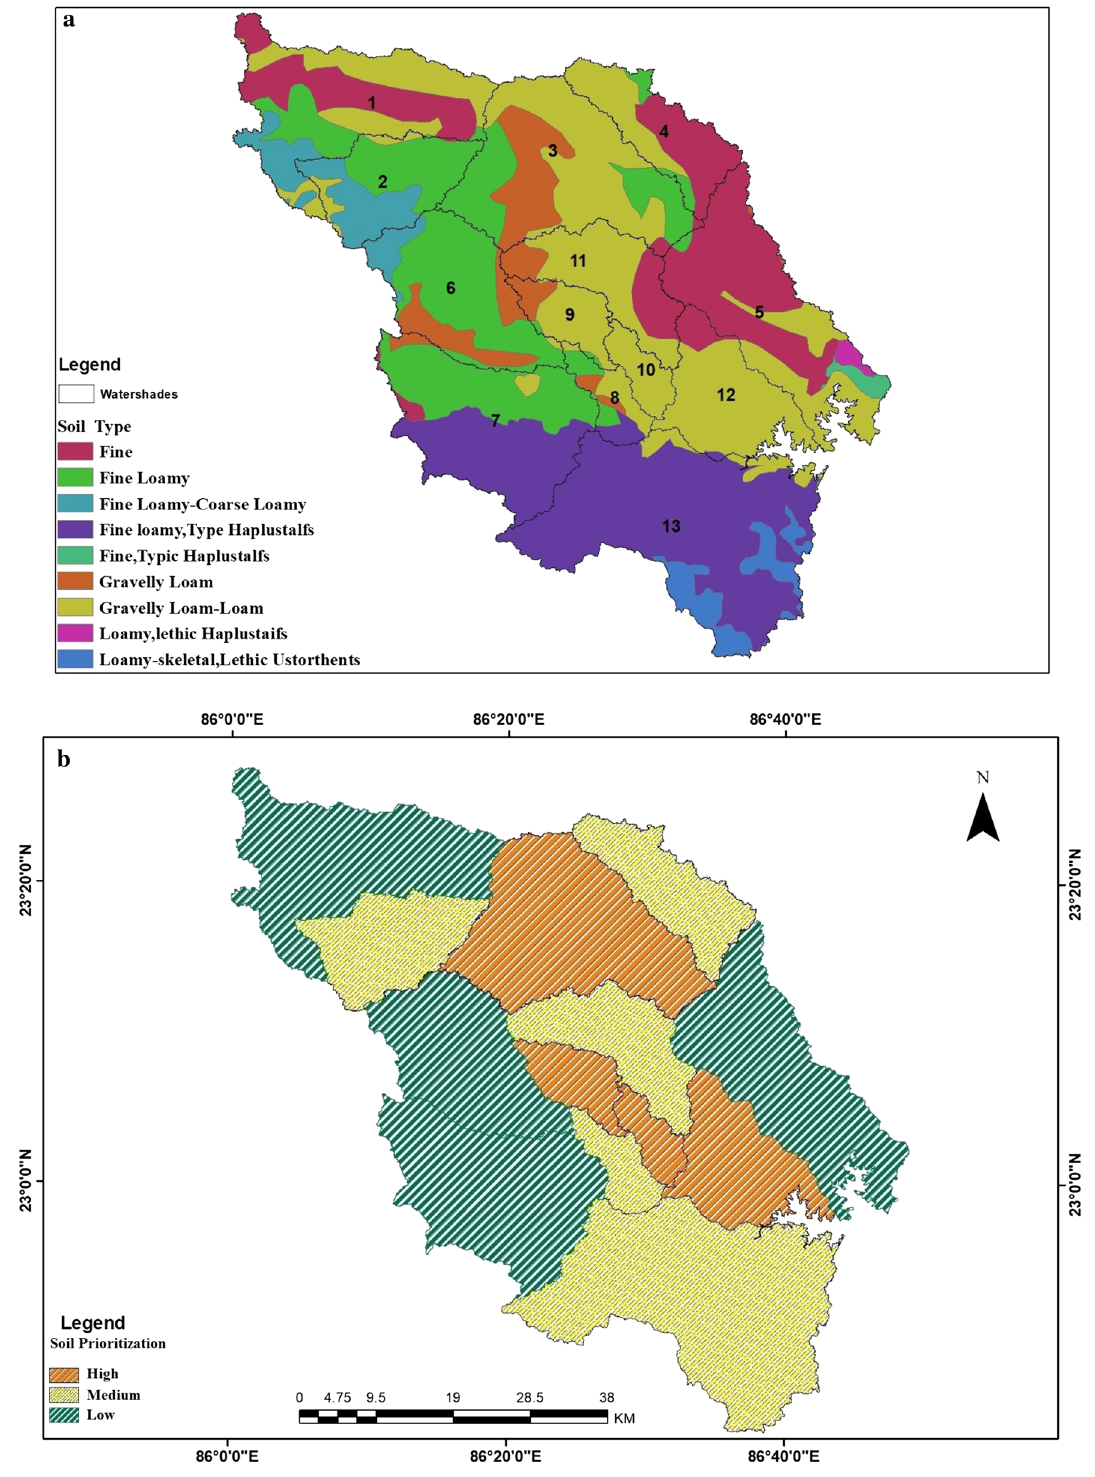
Fig. 8 a Soil type in Kansai–Kumari inter-fluvial site and b priority based on soil type analysis in Kansai–Kumari reservoir catchment